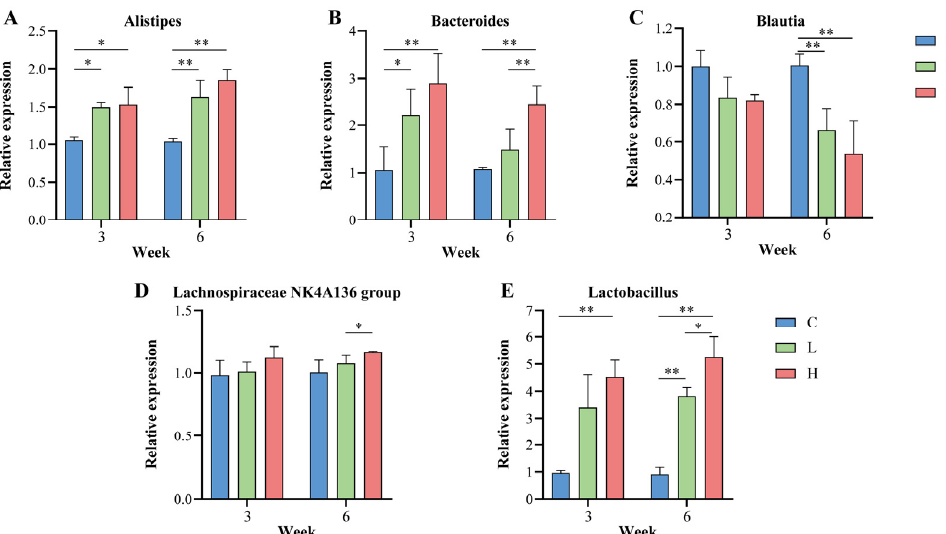
Figure 7. Effect of probiotic combinations on the core Guangxi longevity gut microbiota. ( A – E ) In this study, the intestinal genera of mice at the beginning of the intervention were used as controls to demonstrate the changes in the core longevity genera in the intestine of each group of mice at the middle (3 weeks) and end (6 weeks) of the probiotic combination intervention. ( A ) denotes Alistipes , ( B ) denotes Bacteroides , ( C ) denotes Blautia , ( D ) denotes Lachnospiraceae NK4A136 group , and ( E ) denotes Lactobacillus . * indicates p < 0.05; ** indicates p <